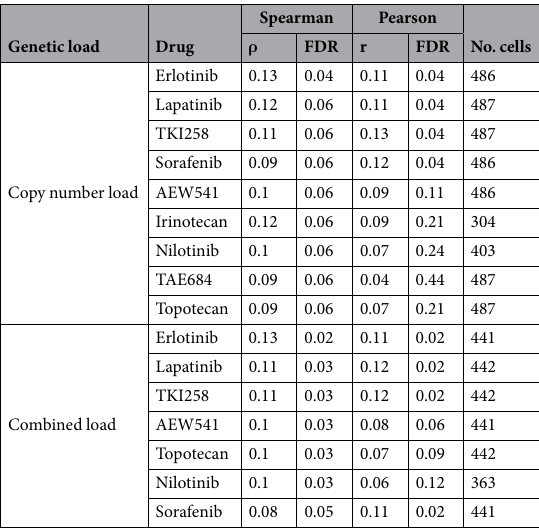
Table 1. Significant associations for the pan-cancer analysis.